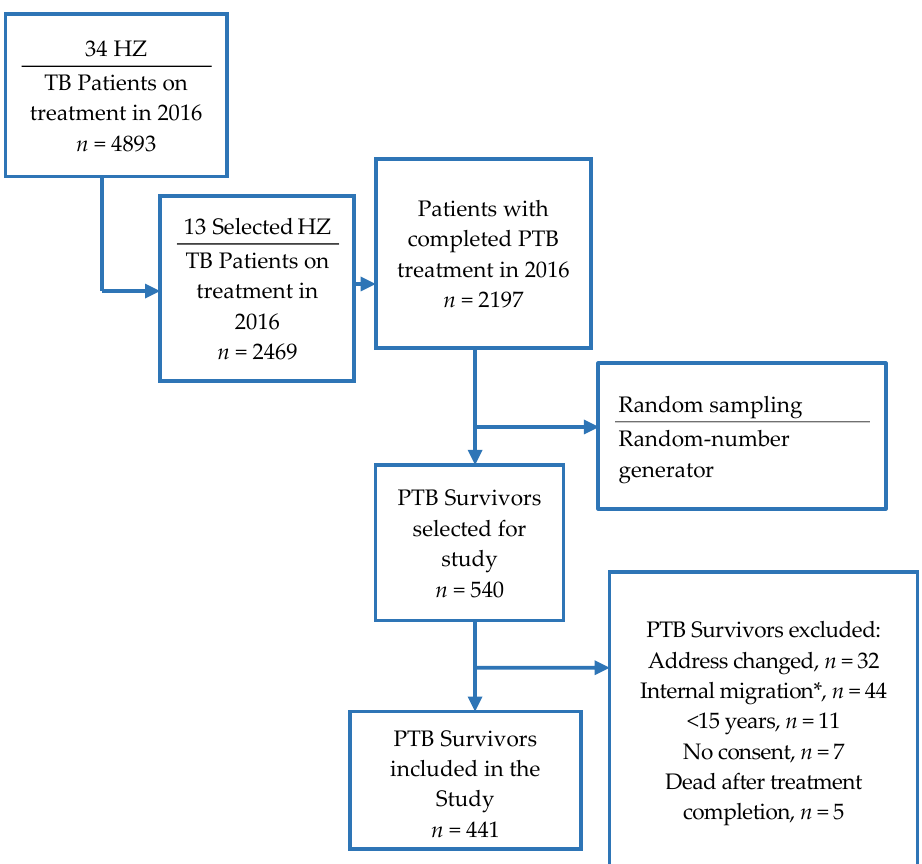
Figure 2. Flow chart. TB: tuberculosis, PTB: pulmonary tuberculosis, HZ: health zone, *: travelling, becoming refugees or displaced for work.